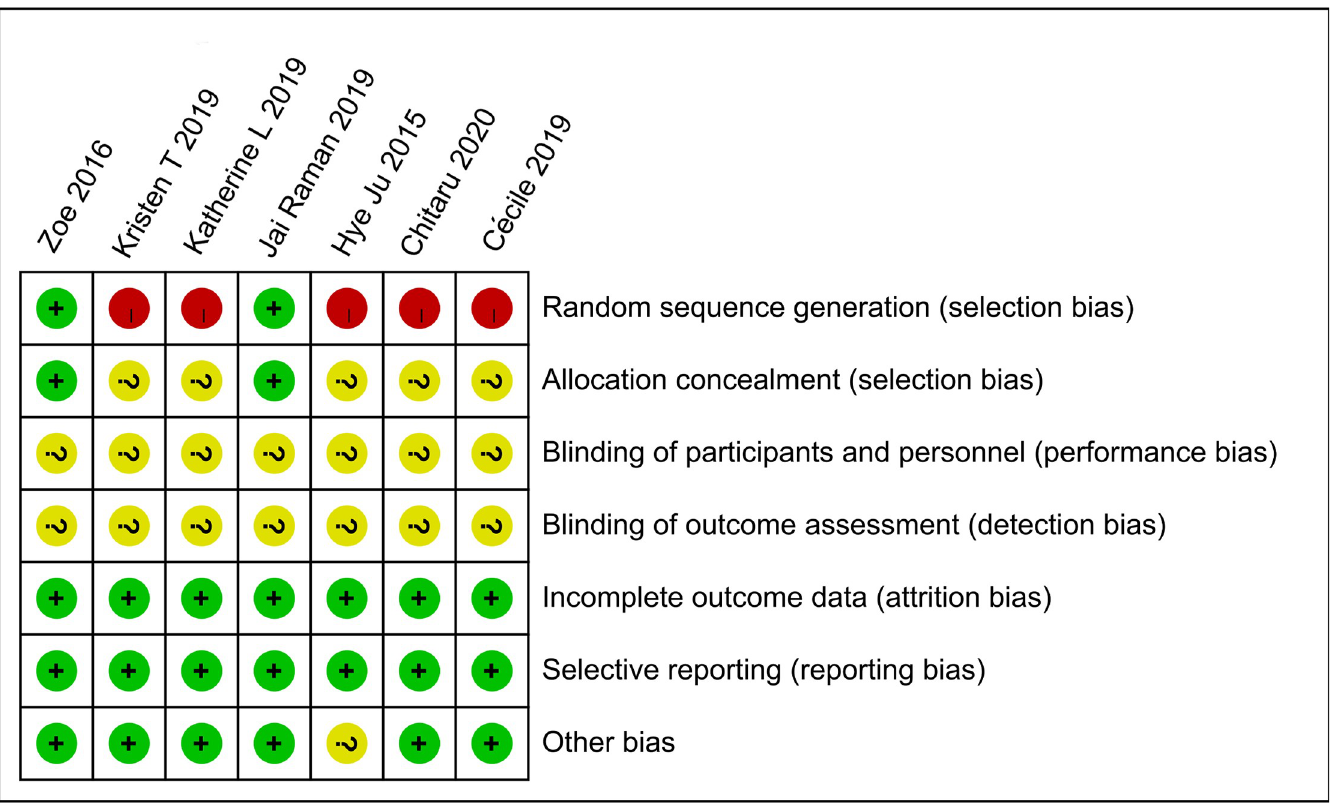
Fig 2. Quality assessment of the included studies.